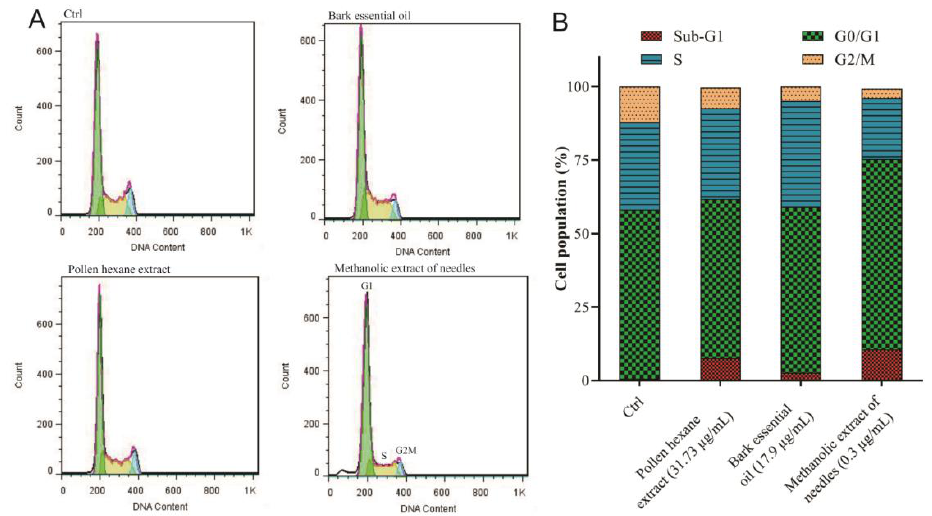
Figure 6. ( A ) Analysis of the cell cycle by flow cytometry in A549 cells after 48 h of treatment with bark essential oil (17.9 µg/mL), pollen hexane extract (31.7 µg/mL), and methanolic needle extract (0.3 µg/mL). ( B ) Cell cycle quantitative results.